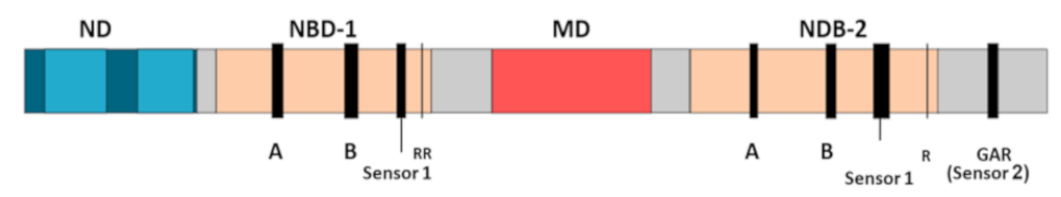
Figure 1. Domain organization of the ClpB monomer [based on 61]. The monomer is composed of the